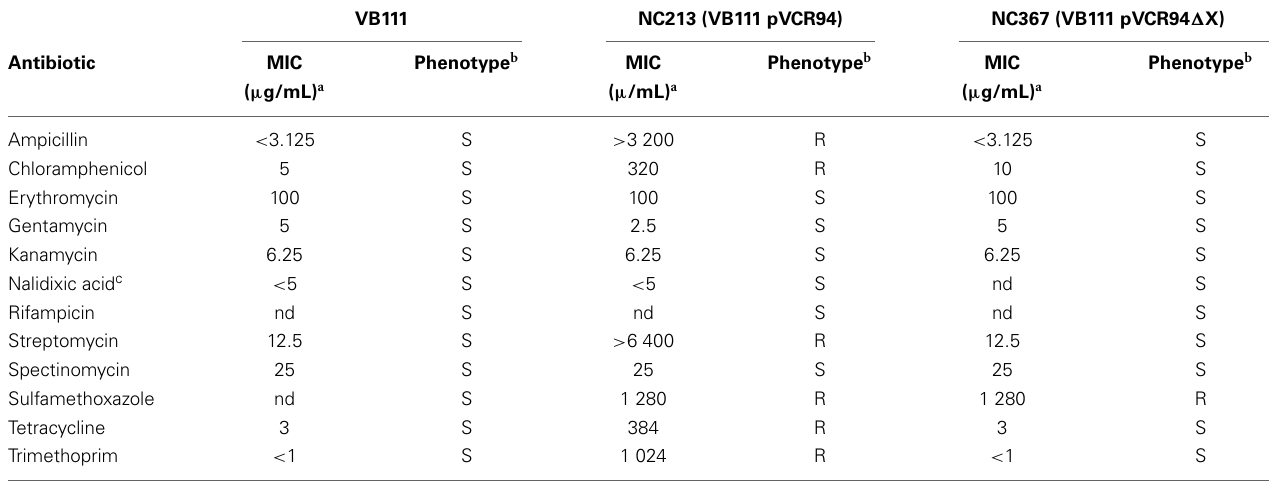
Table 3 | Minimal inhibitory concentrations (MIC) of 12 antibiotics against E. coli carrying pVCR94 or its (cid:2) X